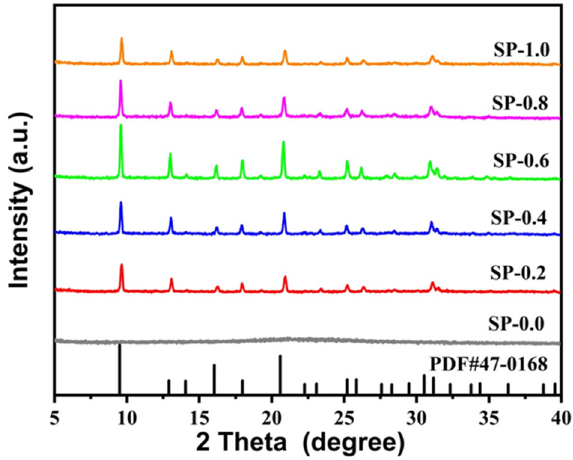
Figure 1. XRD patterns of as-synthesized samples.